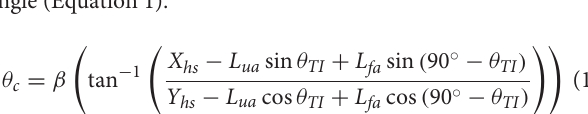
FIGURE 2 | Outline of the procedure from on-court testing to performance prediction. angle (Equation